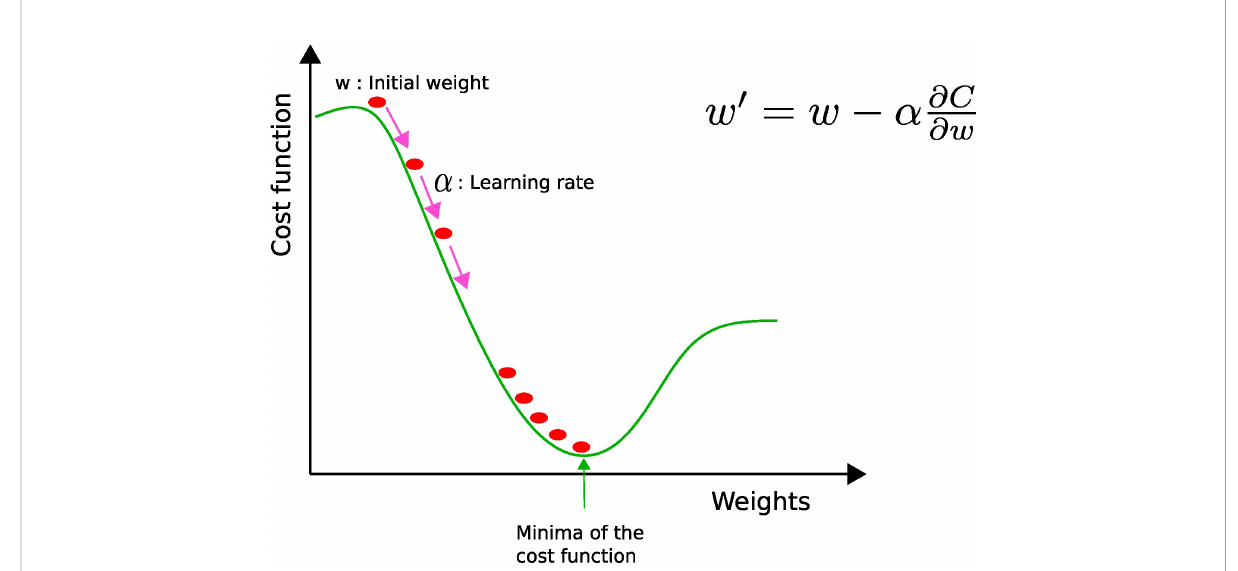
FIGURE 4 Gradient descent: w and w ′ represent the current and updated weights, respectively, and a is the learning rate. The current weight w is moved along the direction of the steepest descent (pink arrow) by the learning rate a .